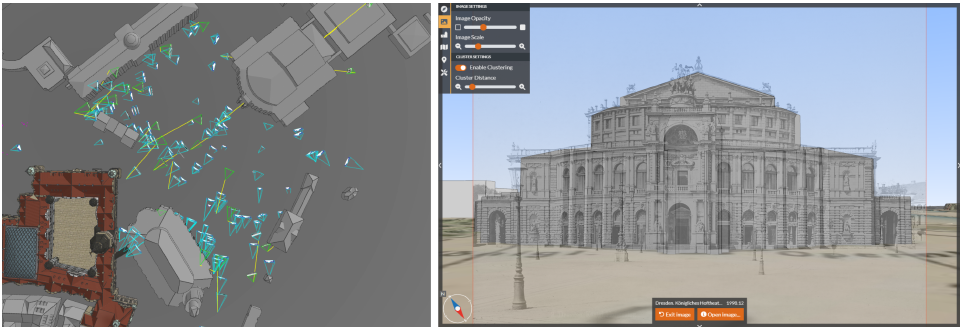
Figure 13. ( Left ): Final reconstruction results as depicted in the 4D browser. ( Right ): Perspective view of one image using the opacity slider to reveal the underlying 3D model of the